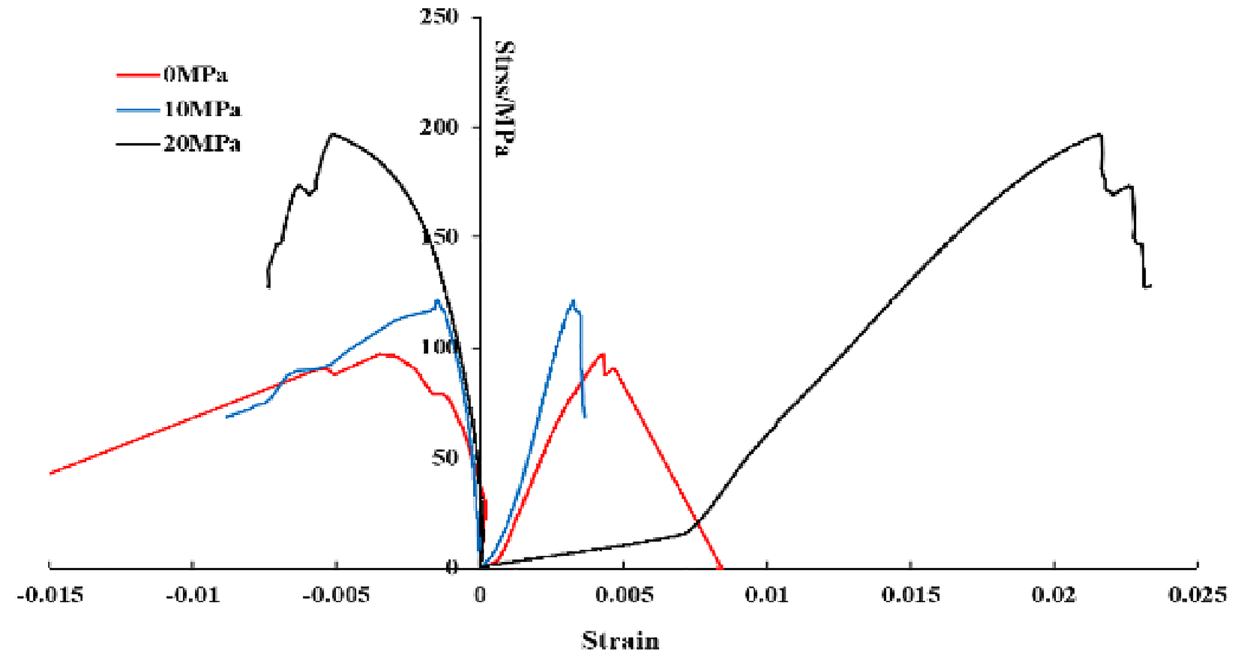
Fig. 4 Shale triaxial stress–strain